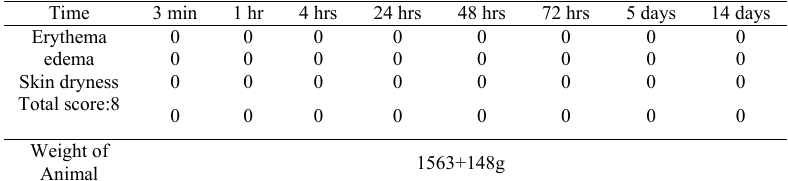
Table 4: Skin reactions of rabbit 1 after 3min, 1hrs,4 hrs,24 hrs,48 hrs , 72 hrs,5 days and 14 days to GBE-SLN Table 4. Skin reactions of rabbit 1 after 3min, 1hrs, 4 hrs,24 hrs,48 hrs , 72 hrs,5 days and 14 days to GBE-SLN